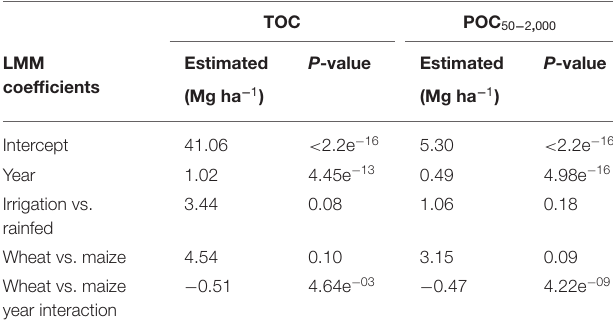
TABLE 2 | Estimations from the linear mixed-effects model (LMM) for the changes in time of TOC and POC 50 − 2,000 .